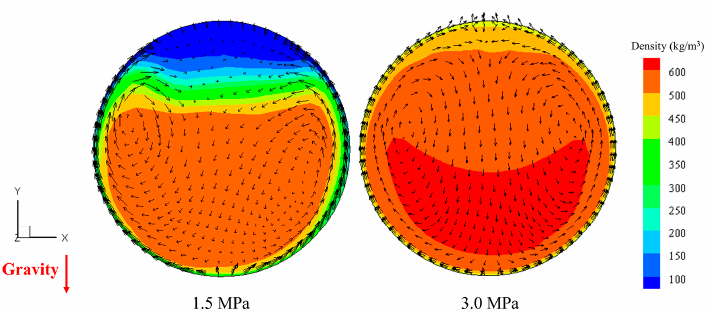
Figure 7. Distribution of velocity vectors and densities at cross-section Z = 325 mm (numerical results of Cases 1 and 2).